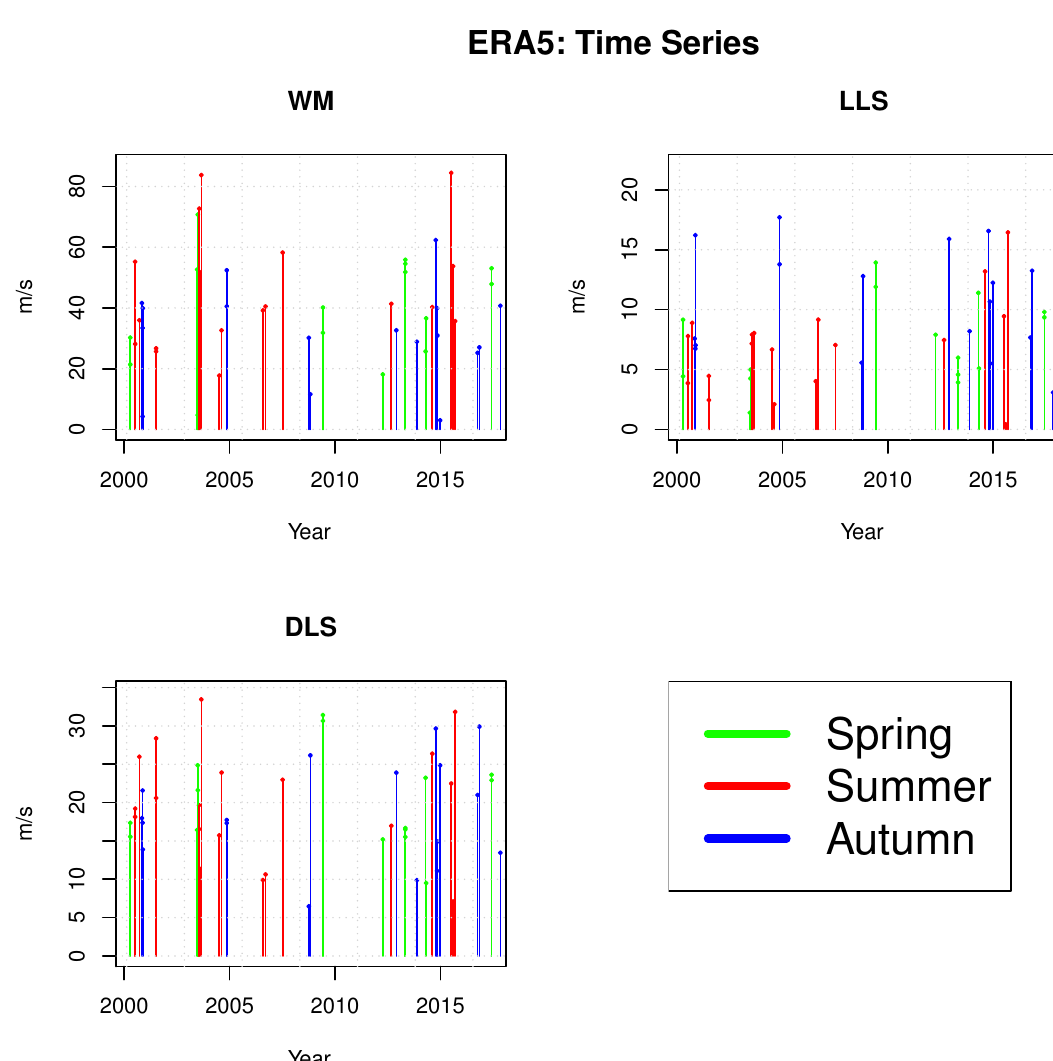
Figure 2. Time Series of updraft maximum vertical velocity (WM) and wind shear (LLS and DLS) extracted from ERA-5 at the 6 h time step closest to the occurrence of the tornadoes (TS1). The height of the bars indicates the magnitude of the variable, while the color marks the season when tornadoes occurred (see also Figure